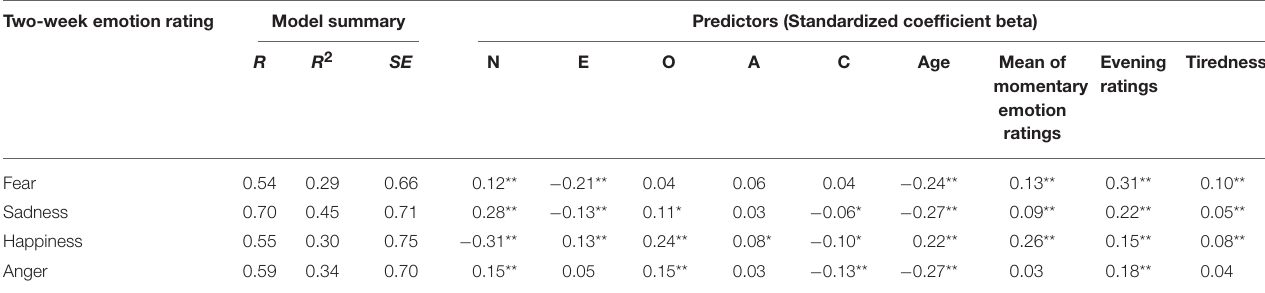
TABLE 6 | Multiple regression analysis of emotion ratings across the 2 weeks—mean of respective momentary emotion ratings, respective evening emotion ratings, personality traits, tiredness, and age as predictors. Two-week emotion